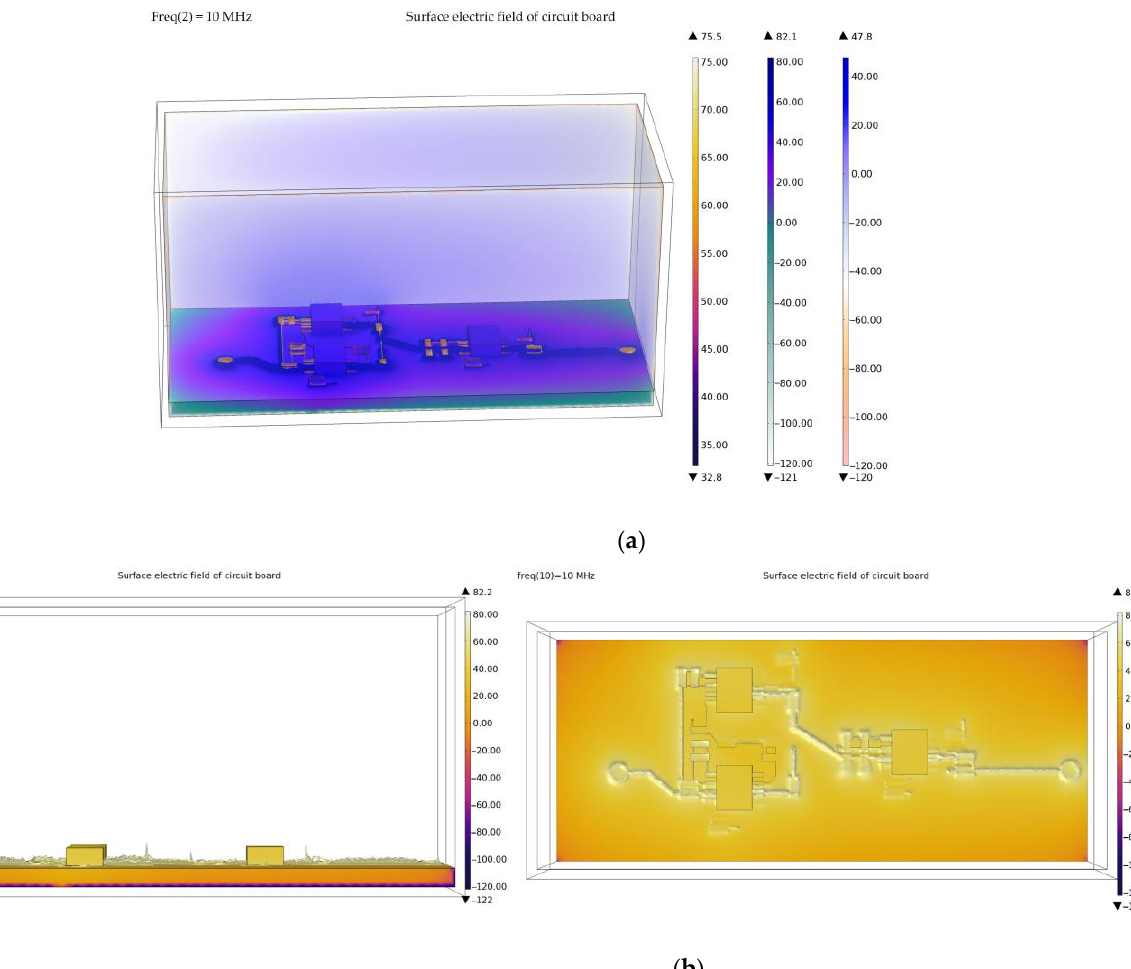
Figure 6. Simulation results of surface electric field of signal conditioning circuit board under transient signal input. ( a ) Surface electric field on the inner surface of signal conditioning sensor; ( b ) Electric field on the surface of signal conditioning circuit board.